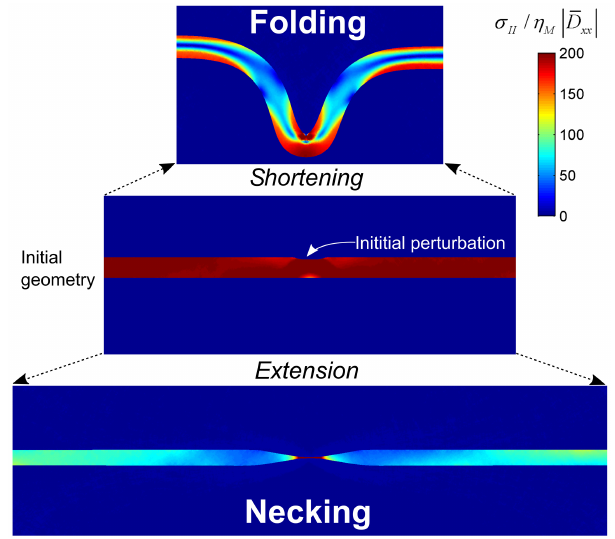
Figure 4. Numerical simulations of folding and necking resulting from layer-parallel shortening and extension, respectively, of the same competent layer with the same initial lateral thickness vari- ation (initial perturbation). The model was initially 20 times wider than the initial layer thickness and the medium above and below the layer was 5 times thicker than the layer. The initial perturbation was introduced as a reduction in the layer thickness by 10%, with the width of this perturbation equal to the layer thickness. The layer in- terface at the two edges of the perturbation has been smoothed to avoid numerical inaccuracies. The geometries are the result of finite element simulations (performed for this study) with a reference vis- cosity ratio of 100, a power-law exponent of the layer of 10 and of the embedding medium of 3. The colours indicate the square root of (cid:18) (cid:16) (cid:17) 1 / 2 (cid:19) σ II = τ 2 xx + τ 2 xy the second invariant of the stress tensor , which is non-dimensionalised by dividing it by the product of ma- (cid:12) (cid:12) ¯ D trix reference viscosity times bulk deformation rate ( η M (cid:12) (cid:12) ) . For xx the initial geometry, the value of σ II in the layer is close to the abso- lute value of the basic state deviatoric stress ¯ τ xx = 2 η ref ¯ D xx . With progressive folding and necking, the average stress of the layer– matrix system decreases. For necking, high stresses are localised in the neck. The corresponding structural softening of the folding and necking simulations is shown in Fig.